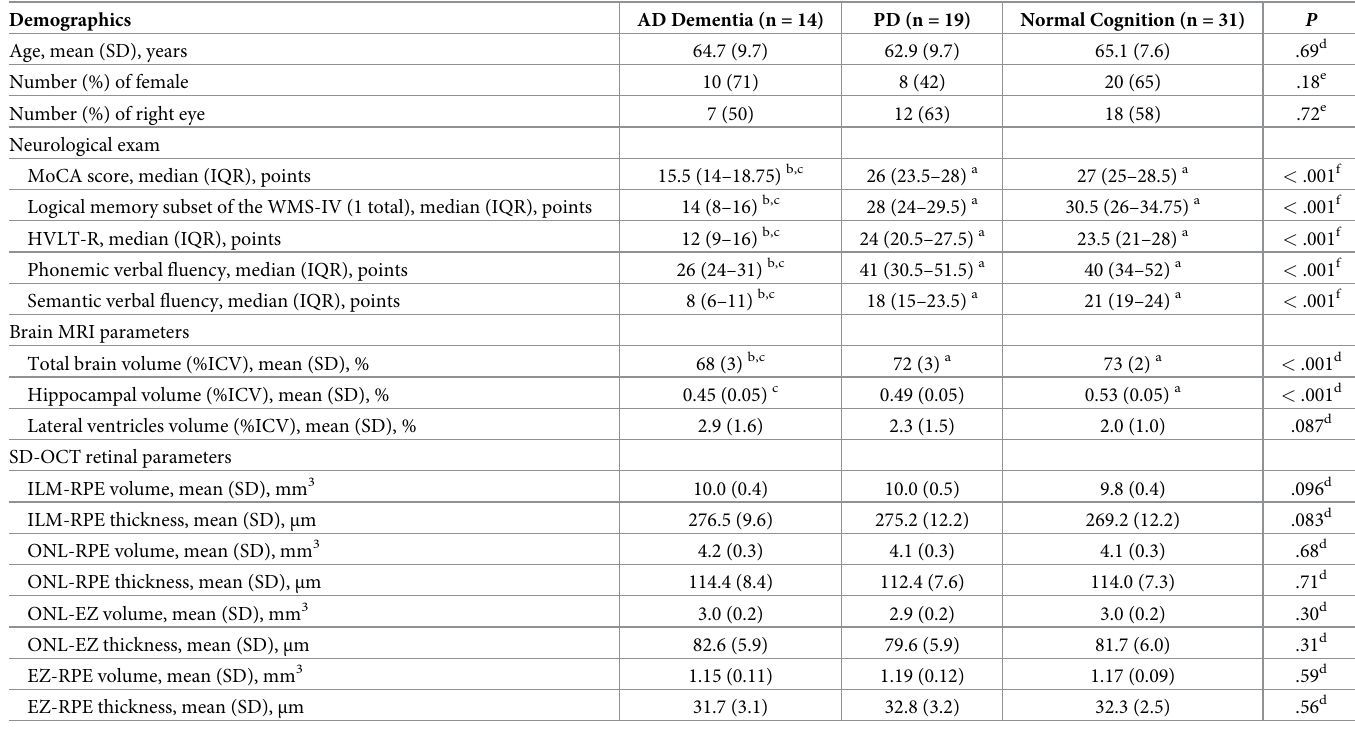
Table 1. Patients demographics, brain MRI and SD-OCT retinal